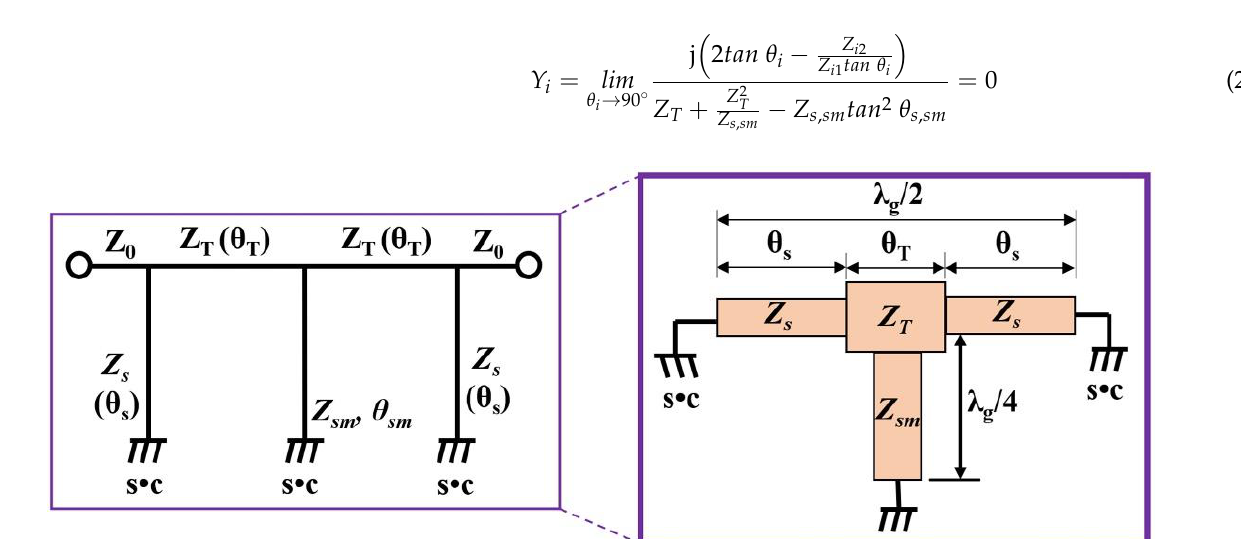
Figure 4. SIR structure of the proposed BPF with transmission line and short stub.